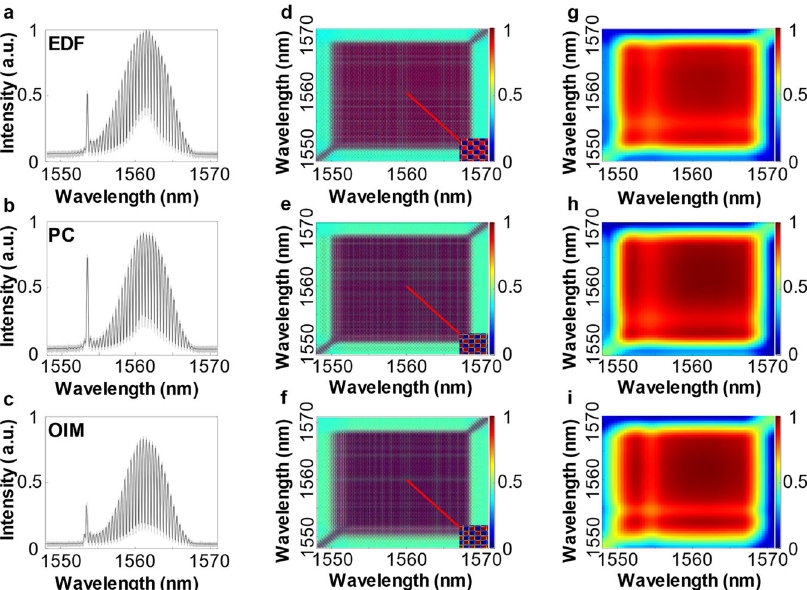
Fig. 5 Spectral coherence of solitons output from different ports. a – c The one-dimensional interference fringe results of the EDF port, PC port, and OIM port. The one-dimensional spectral coherence increases sequentially. EDF: erbium-doped fi ber; PC: polarization controller; OIM: optical integrated module. d – f The two-dimensional interference fringe results. The zoom-in image around the central wavelength shows well-de fi ned square-grid pattern with high contrast, indicating their coherence are quite well. g – i The estimated cross-spectral densities calculated from ( d – f ). The closer the color is to red, the closer the CSD is to 1, which means better spectral coherence. The two-dimensional spectral coherence also increases sequentially. Table 2 The parameters used in the numerical simulation of the period-doubling bifurcation. SMF